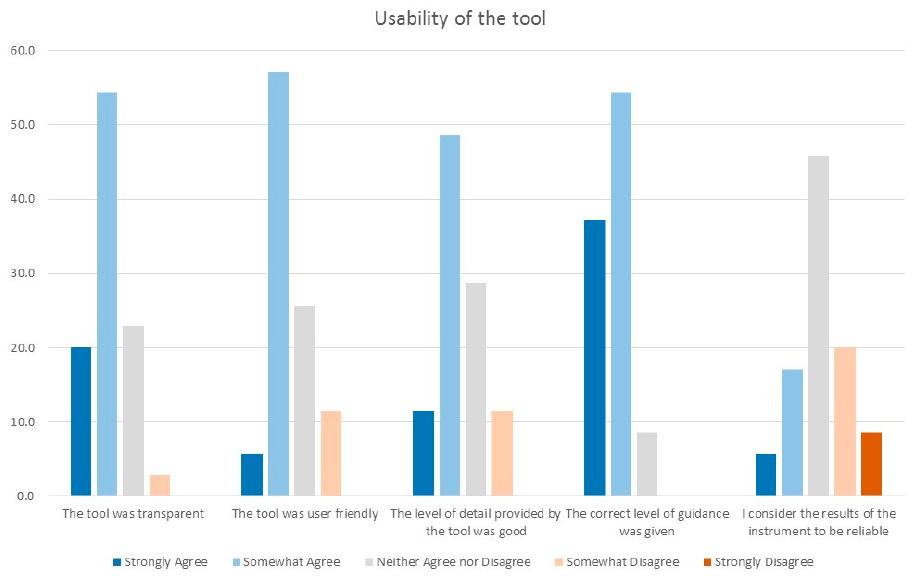
Figure 7. Usability of the COLLAGE tool.